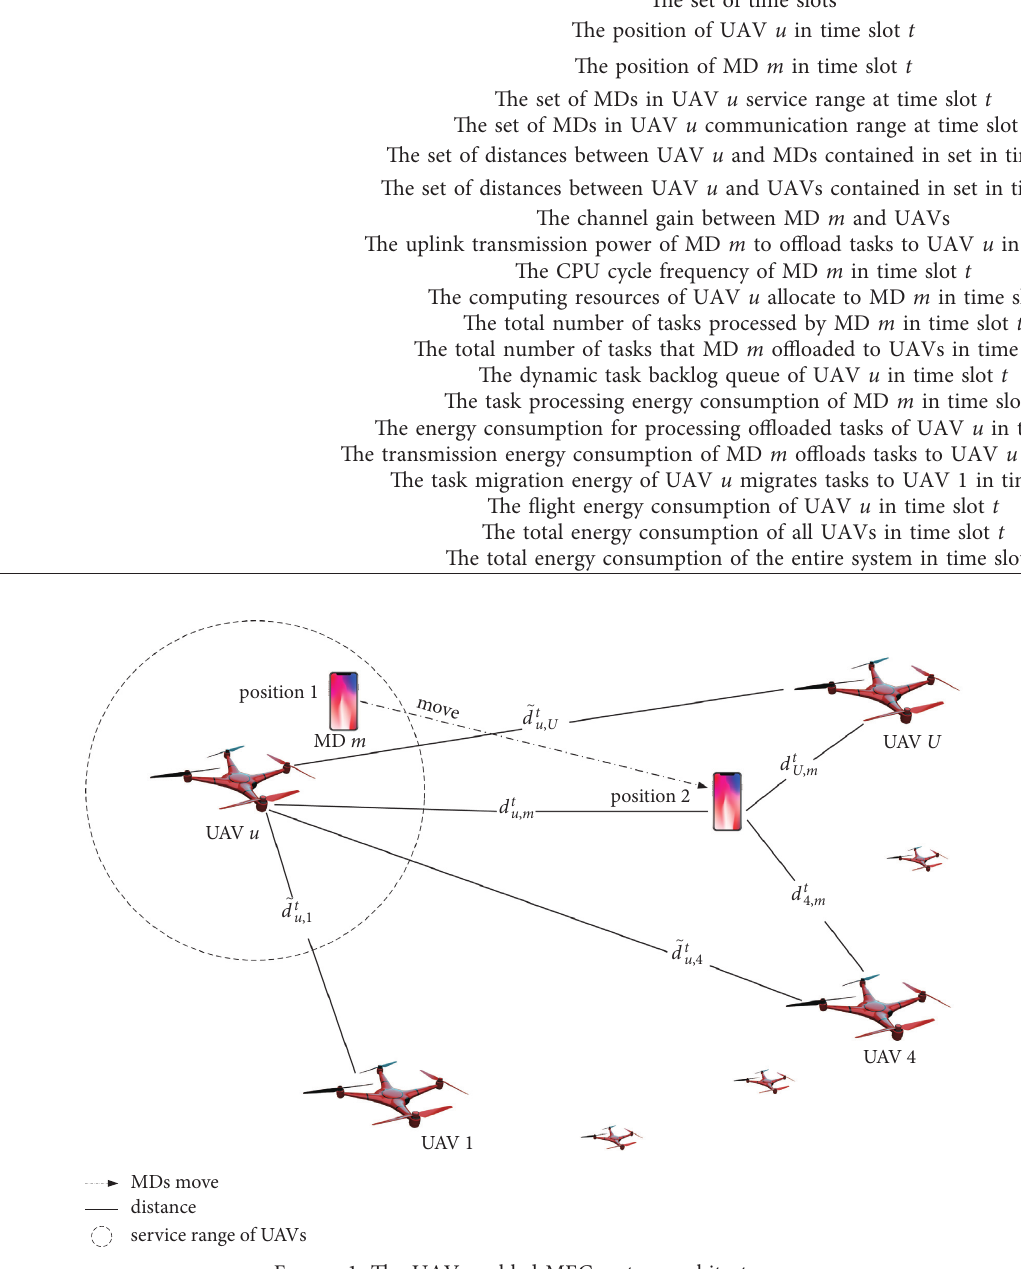
Figure 1: The UAV-enabled MEC system architecture.